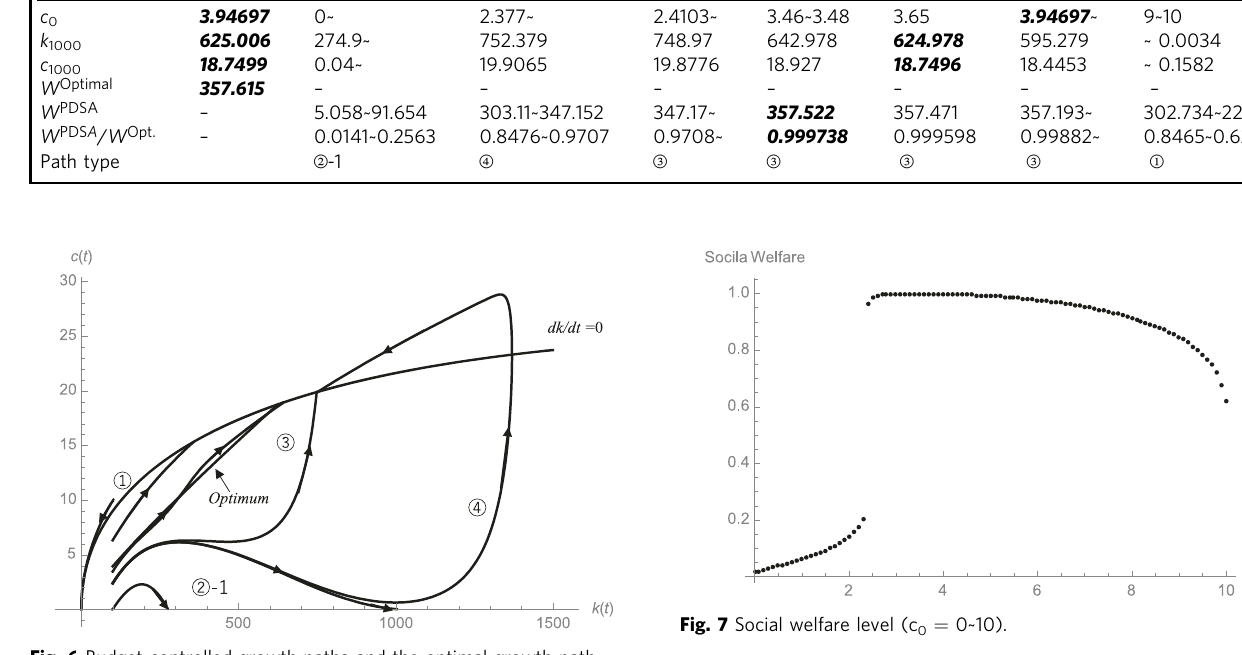
Table 2 Optimal growth path for k 0 = 100 and each evaluation indicator for the budget-controlled (PDSA) growth path. Optimal